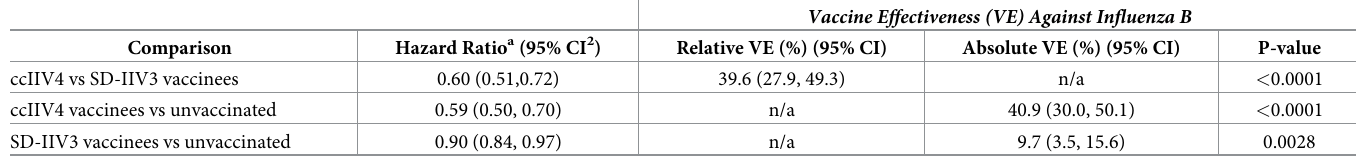
Table 3. Vaccine effectiveness against influenza B of cell culture and egg-based inactivated influenza vaccines among 4-64-year-olds, Kaiser Permanente Northern California 2017–18.